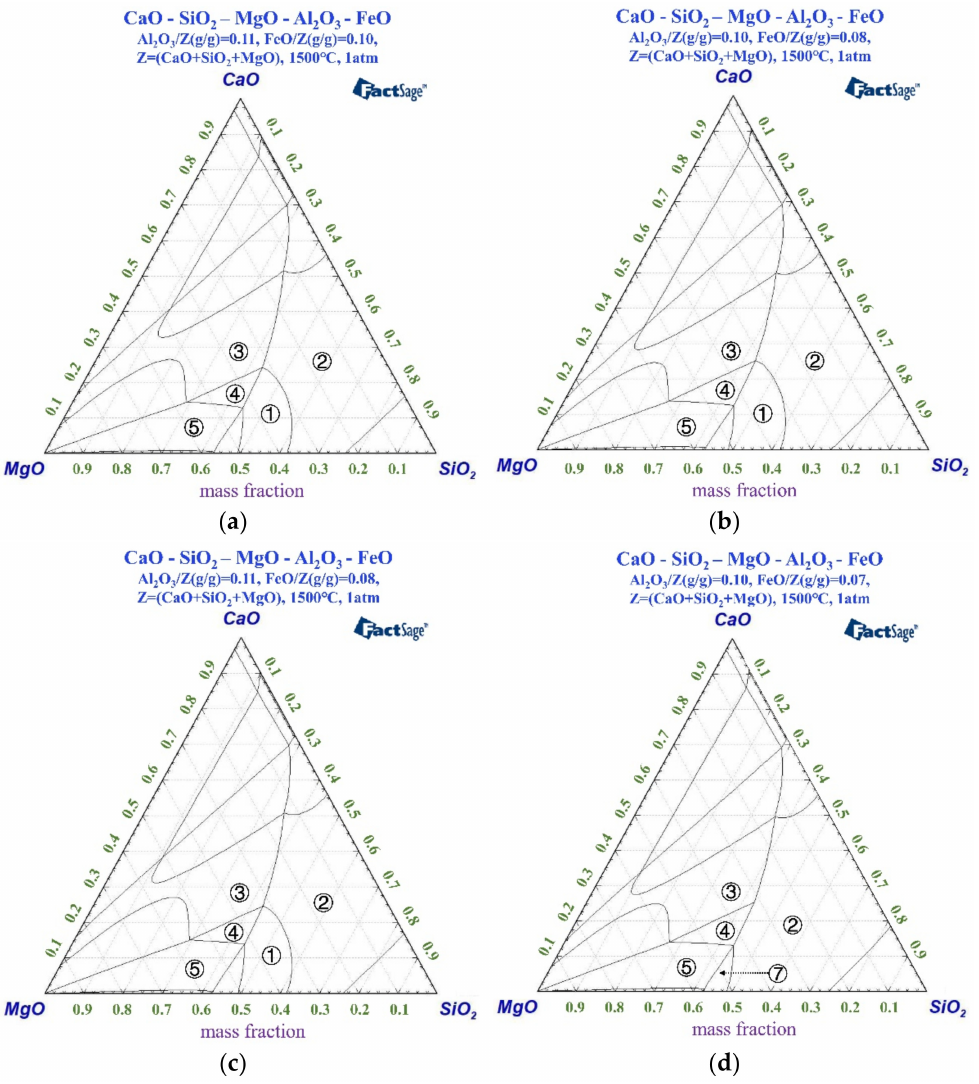
Figure 13. Quinary phase diagrams of slag at 1500 ◦ C. ( a ) H1 − A; ( b ) H1 − B; ( c ) H2 − A; ( d ) H2 −